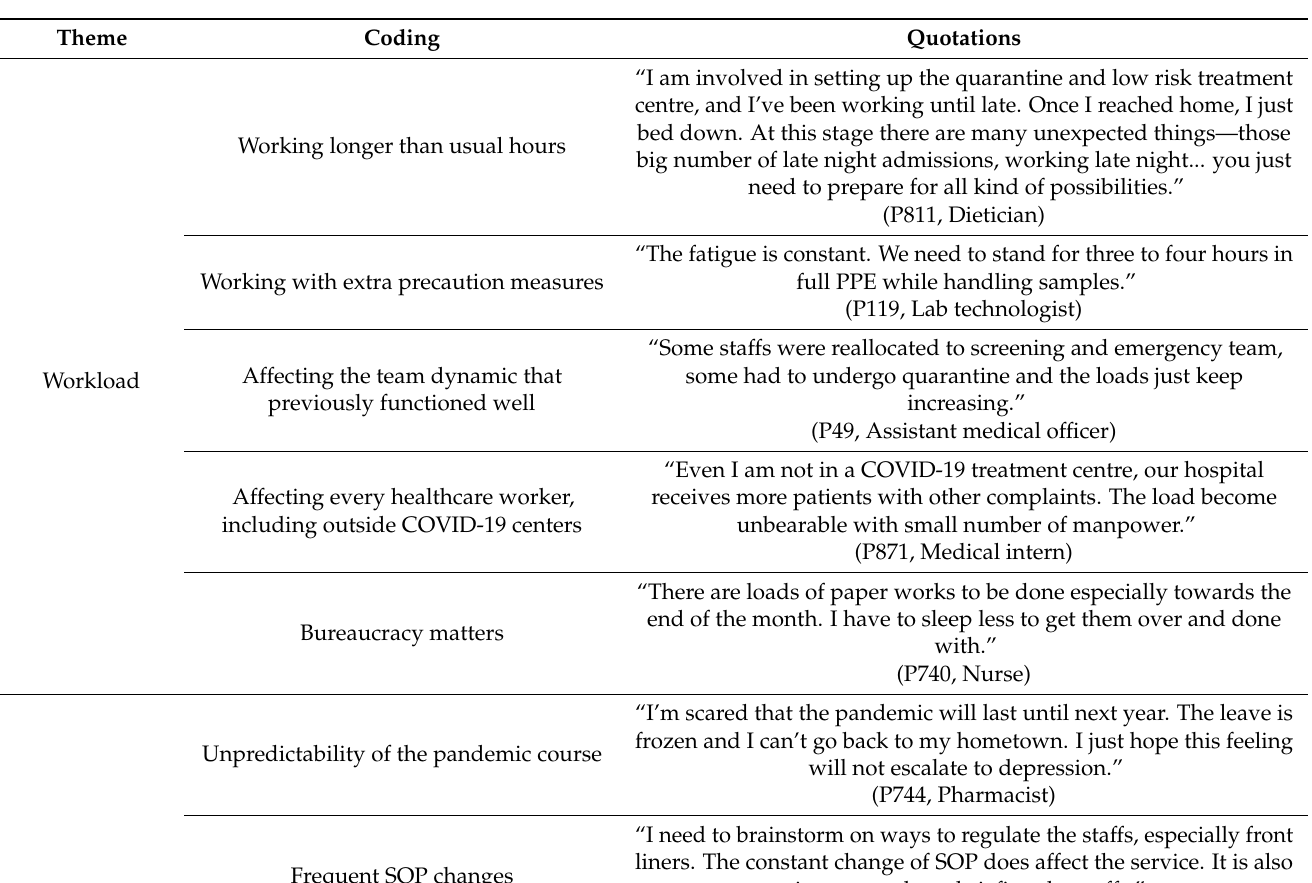
Table 5. Common self-reported causes of burnout in